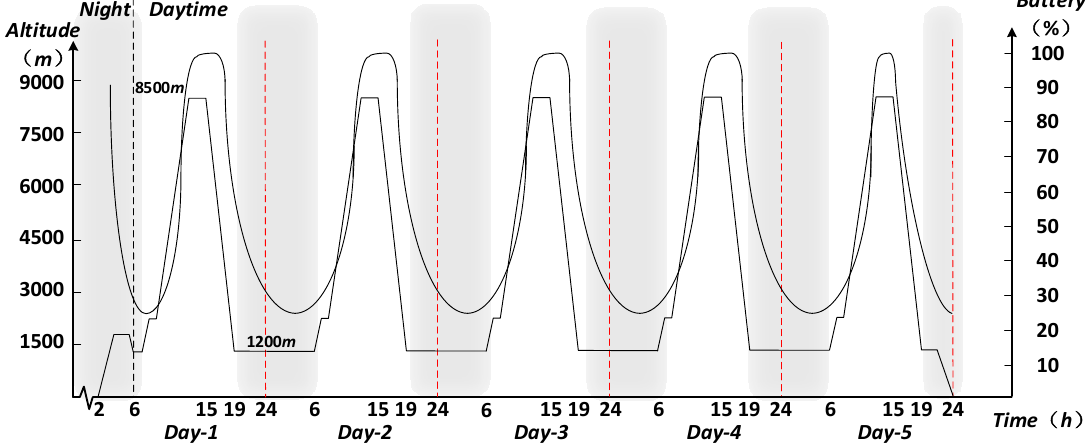
Figure 13. Correspondence between flight height profile of UAV and charge-discharge cycle.